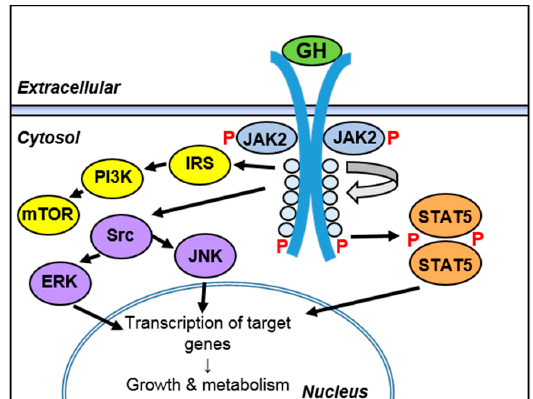
Figure 2. Intracellular GH signaling. GH binds to a pre-formed GHR dimer on the cell surface, leading to a conformational change in the intracellular domain that results in phosphorylation (P) and activation of signal transducer and activator of transcription (STAT)5 through Janus Kinase (JAK)2. Phosphorylated (active) STAT5 then travels to the nucleus and regulates the transcription of GH target genes. GHR can also signal through the mTOR pathway through insulin receptor substrate (IRS) and phosphoinositide-3 kinase (PI3K), and can activate c-Jun N-terminal kinase (JNK) and extracellular signaling regulated kinase (ERK) through activation of Src kinase. Arrows show activation sequence and nuclear translocation downstream of GHR.